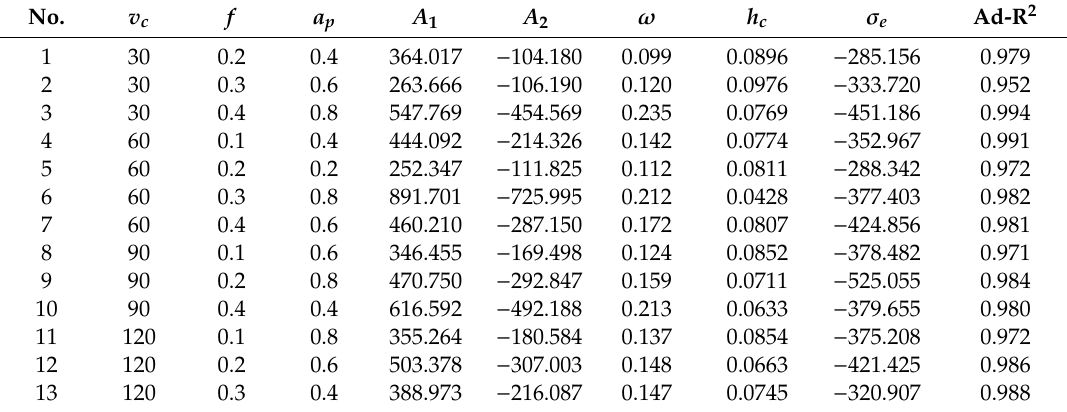
Table 5. The key parameters of circumferential residual stresses fitting function ( v c : cutting speed in m / min; f : feed rate in mm / r; a p : depth of cut in mm).